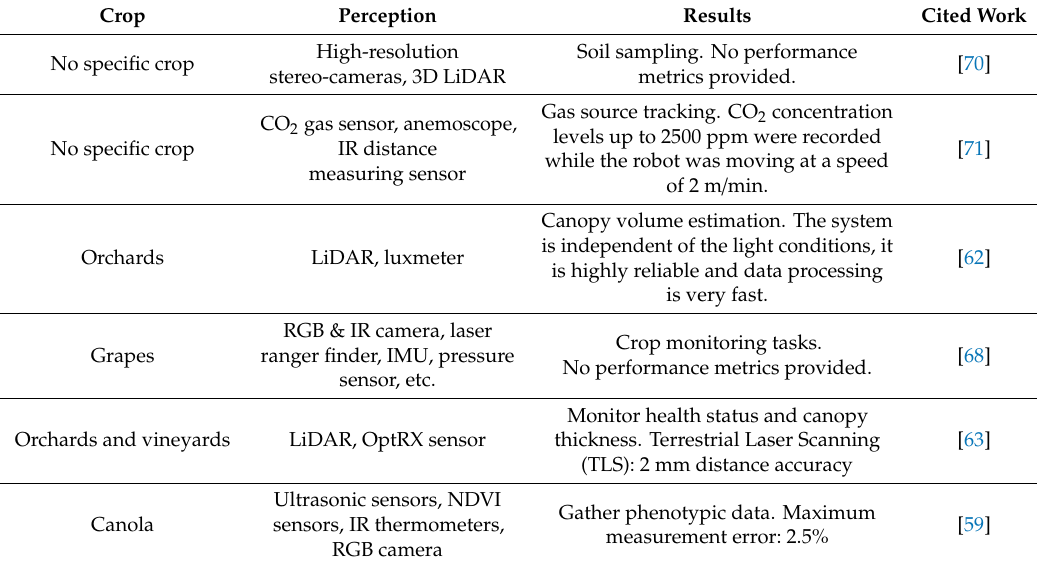
Table 4. Plant vigor monitoring agrirobotic systems for various